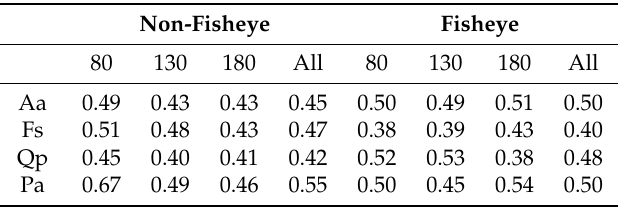
Table 3. RMSE of diameter estimation (cm) (Aa: Abies alba ; Fs: Fagus sylvatica ; Qp: Quercus petraea ; Pa: Picea abies ).